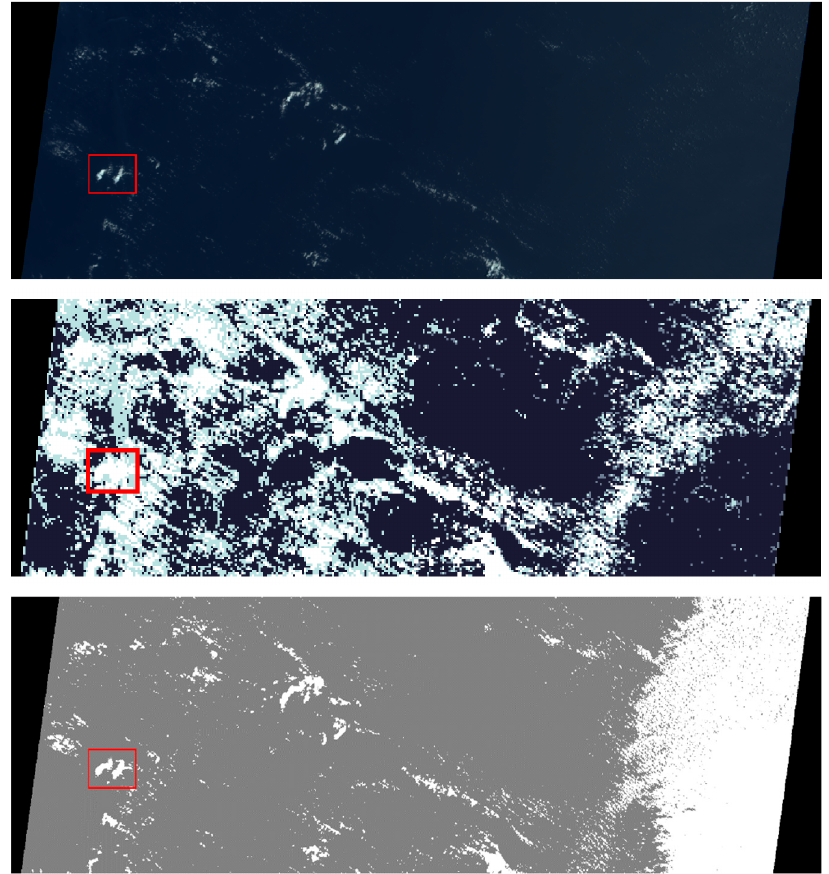
Figure 11. The RGB image, the RCCM, and the custom cloud mask of Orbit 19726 Block 86, at view angle AN. The region selected for reconstruction is indicated in the red boxes.